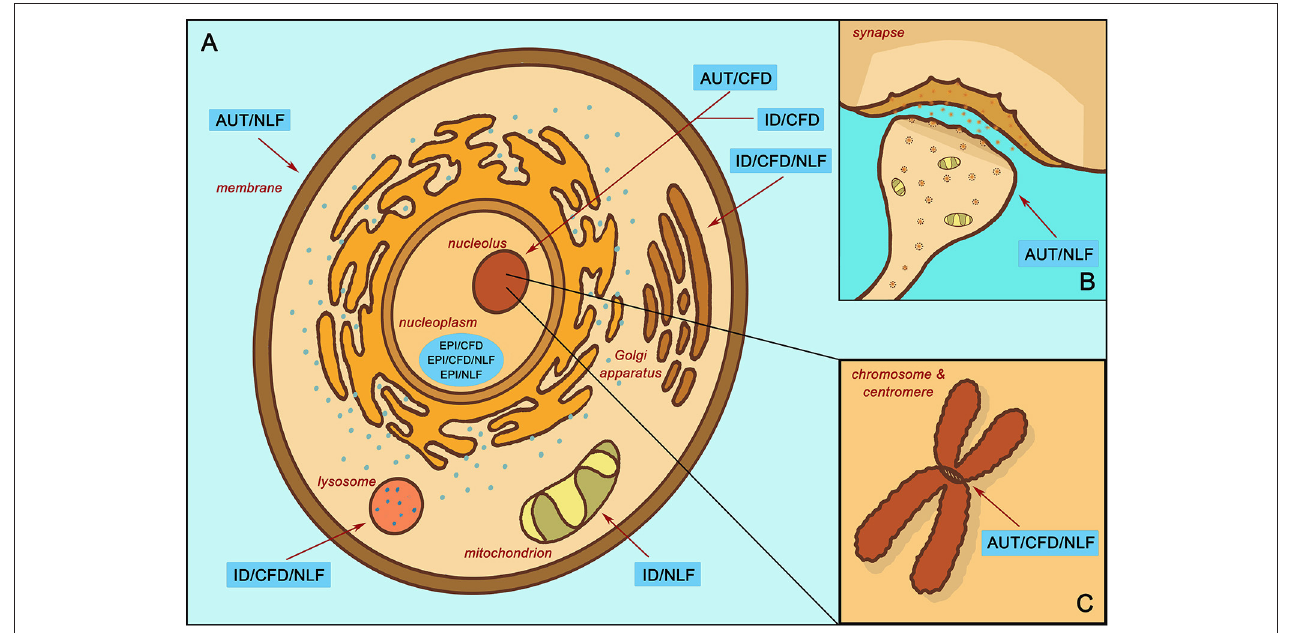
FIGURE 3 | Enrichment localization according to subgroup. (A) Localized enrichment according to subgroups within the main body of the cell. (B) Subgroup enrichment within the synapse. (C) Subgroup enrichment at the chromosome and centromere. Intellectual disability with autism and with/without epilepsy (AUT); intellectual disability with epilepsy and without autism (EPI); intellectual disability without autism or epilepsy (ID); complex facial dysmorphia (CFD); neurodegenerative-like features